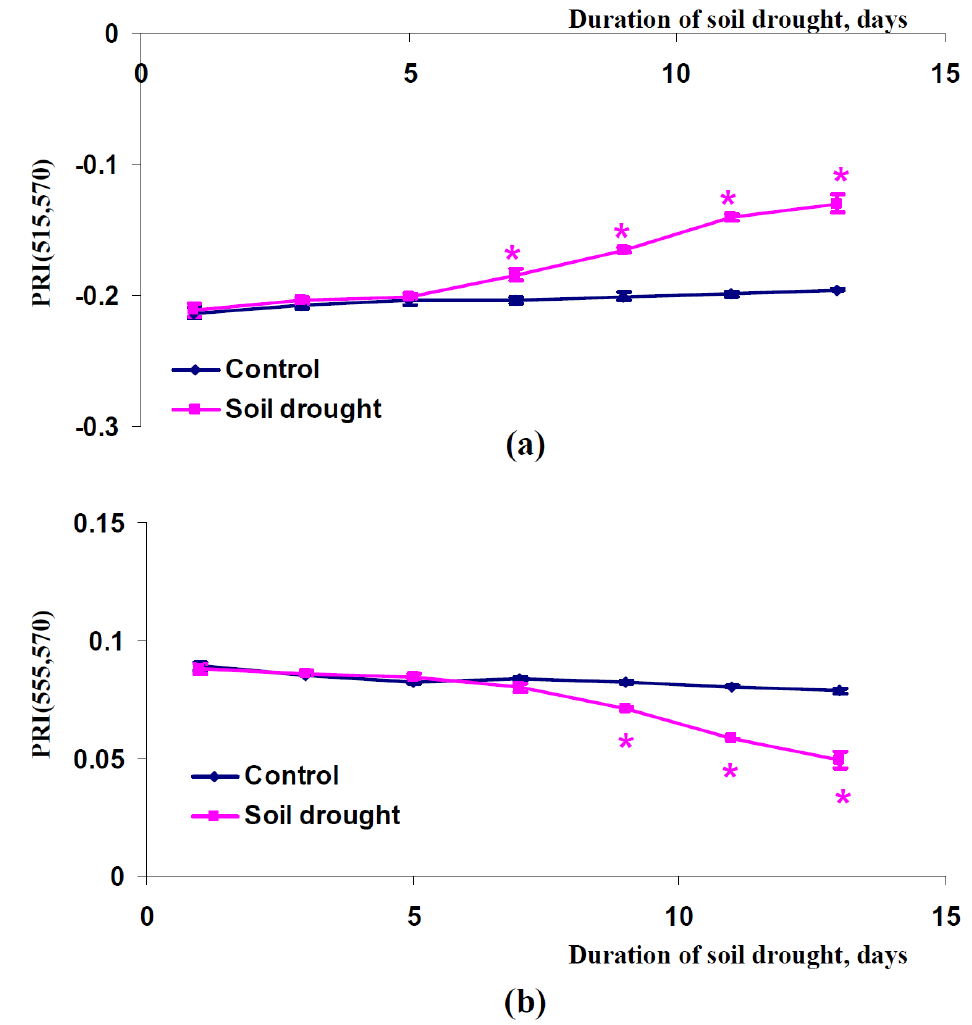
Figure 7. Dependences of the PRI(515,570) ( a ) and PRI(555,570) indices ( b ) in the canopy of pea plants cultivated under conditions of a vegetation room on the duration of the soil drought ( n = 45). *, difference between experimental and control indices was significant ( p < 0.05).